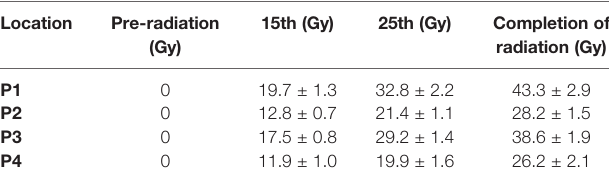
TABLE 2 | Mean radiation dose for different lobes of parotid glands. Location